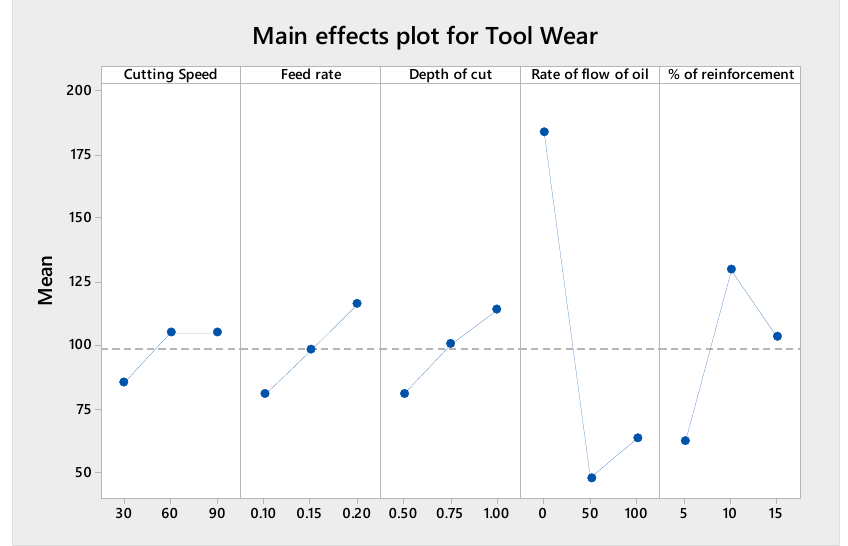
Figure 10. Main effect plots for tool wear.